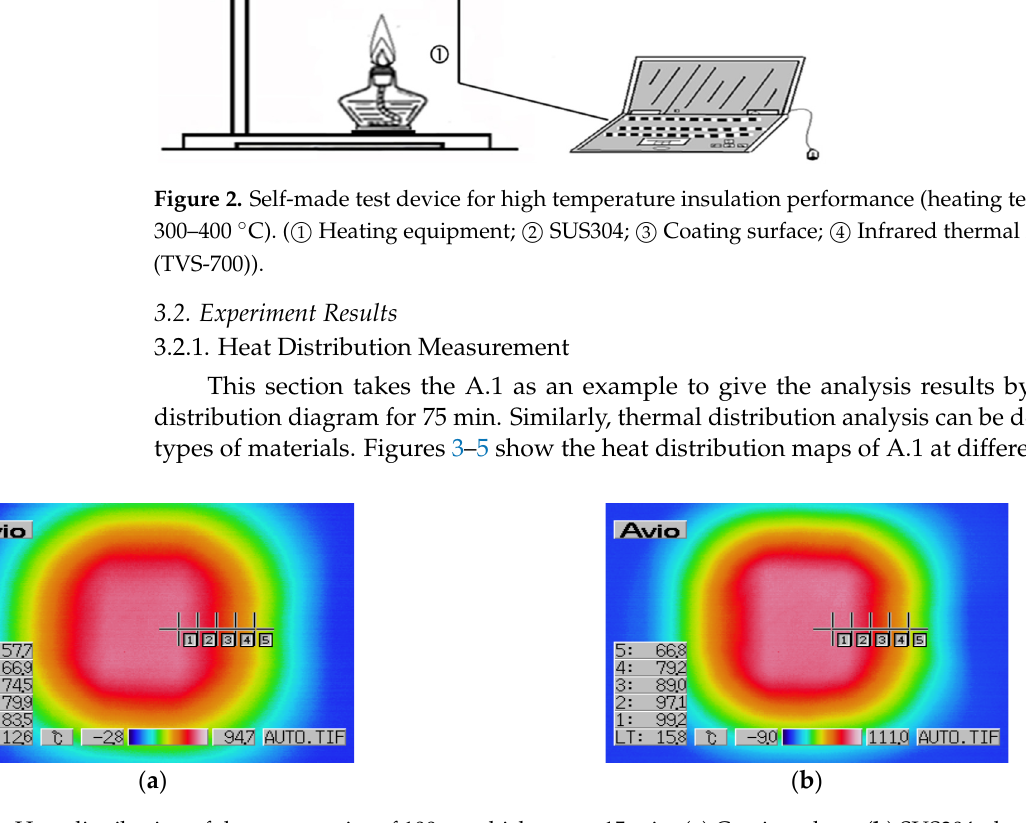
Figure 3. Heat distribution of the center point of 100 μ m thickness at 15 min: ( a ) Coating plane; ( b ) SUS304 plane.